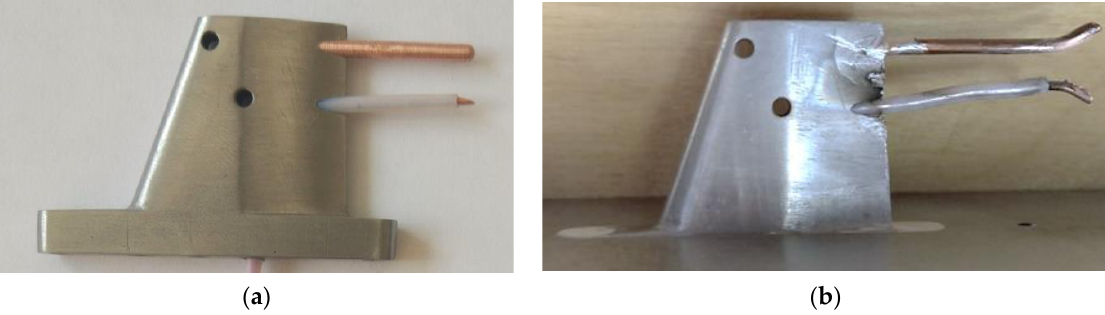
Figure 2. Principal view of the pylon, equipped with fuel injectors and a plasma module: ( a ) Ver.a — straight electrodes; ( b ) Ver.b — angled ends of the electrodes (image after tests).